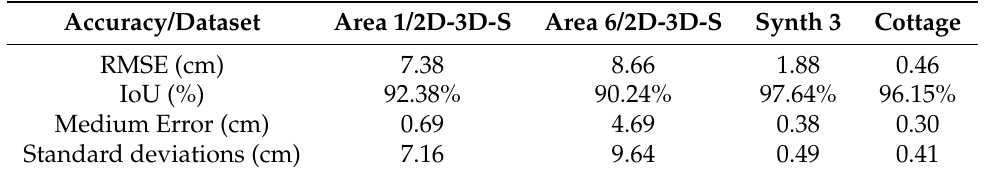
Table 4. Quantitative evaluation of the reconstruction